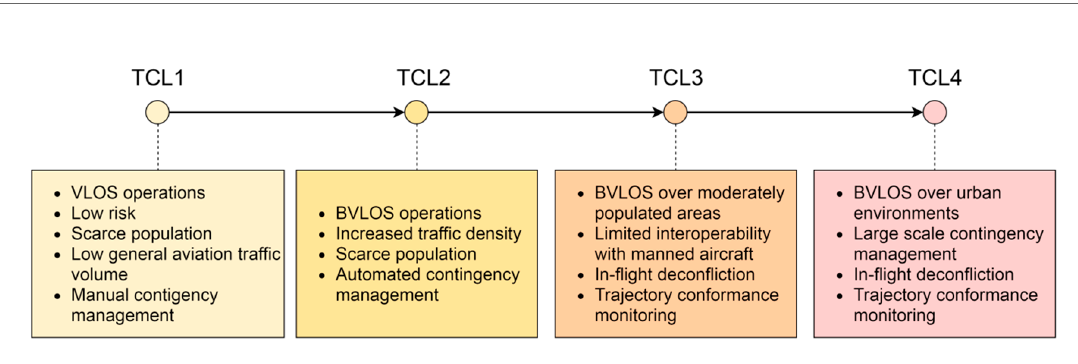
Figure 2. Phases of the UTM project.